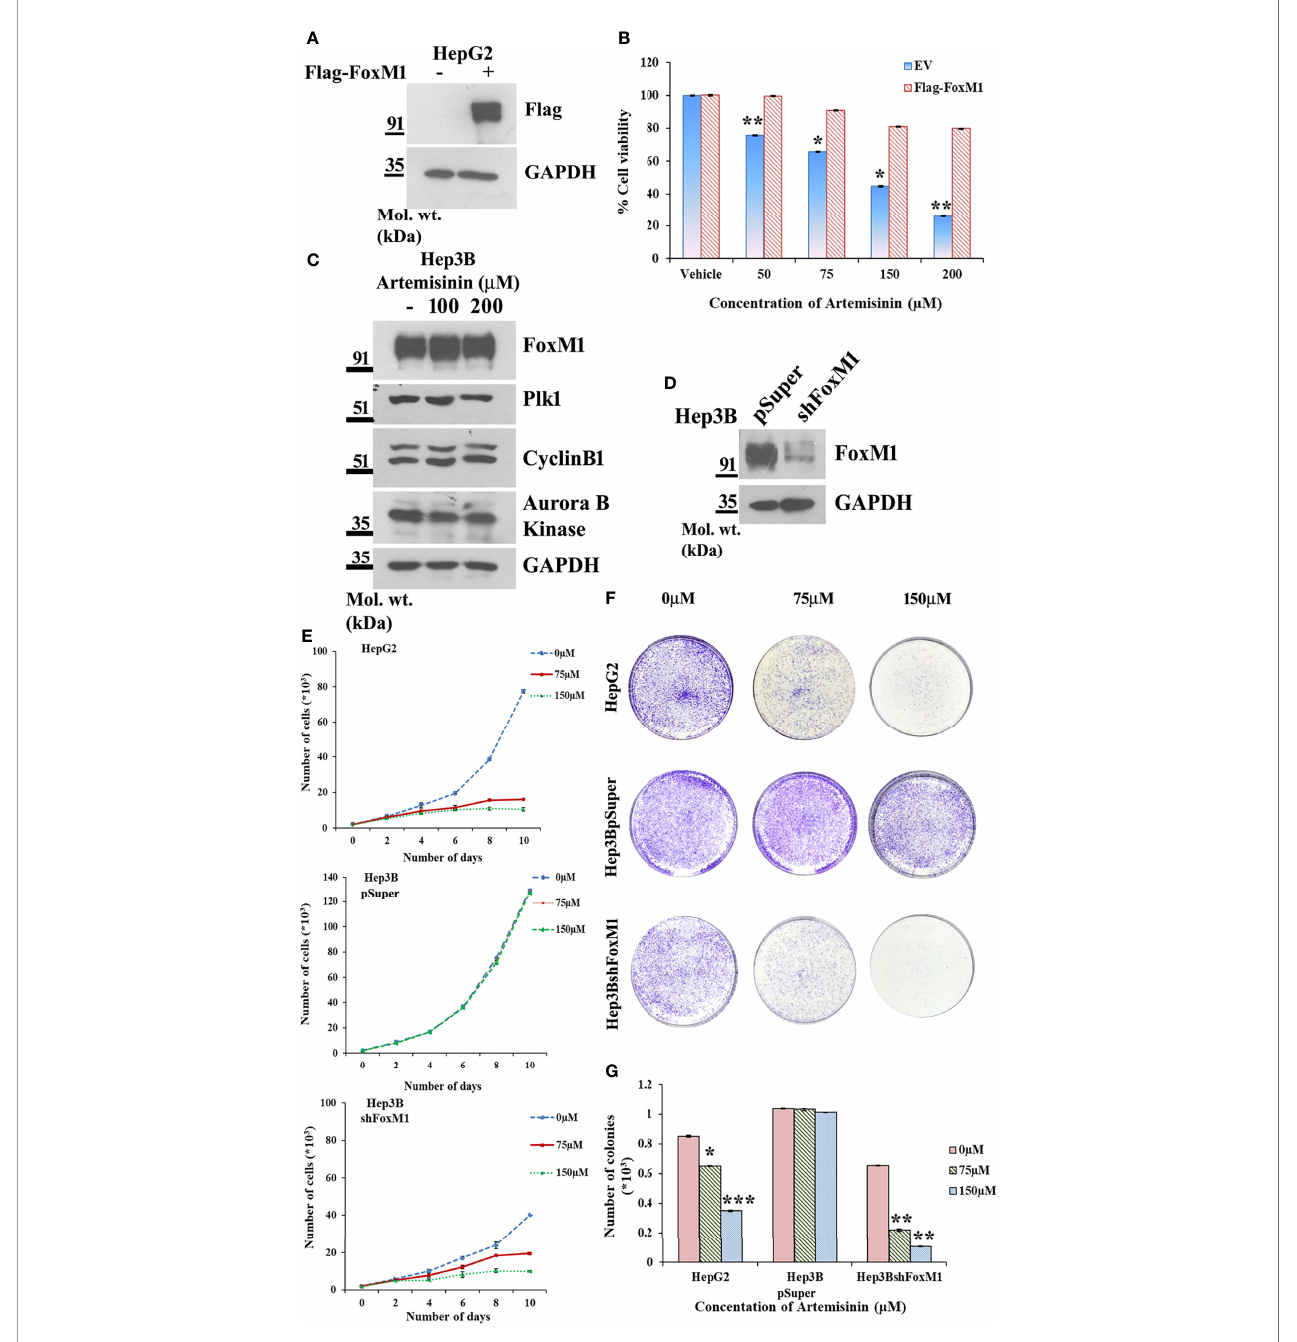
FIGURE 3 | FoxM1 level contributes to Artemisinin-mediated mitigation of cancerous properties of HCC cells. (A) HepG2 cells were transiently transfected with either empty vector or Flag-FoxM1. Equal amount of whole cell lysate was subjected to SDS-PAGE and subsequent immunoblotting for FoxM1. GAPDH was used as a loading control. (B) HepG2 cells overexpressing either empty vector or Flag-FoxM1 were treated with increasing doses of Artemisinin for 48 h and cell viability was examined using MTT assay. (C) Hep3B cells were treated with either vehicle or Artemisinin (100 and 200 µM) for 48 h. Equal amounts of whole cell lysates were subjected to SDS-PAGE and western blotting with antibodies speci fi c for FoxM1 and its transcriptional targets, such as Plk1, cyclinB1 and Aurora B kinase. GAPDH was used as a loading control. (D) Immunoblotting showing the ef fi ciency of FoxM1 knockdown in Hep3BshFoxM1 stable cell line relative to control Hep3BpSuper cells. (E) The comparative proliferative rates of HepG2, Hep3BpSuper and Hep3BshFoxM1 cells following exposure to Artemisinin for 48 h. (F) Representative images and (G) graphical presentation of the stained colonies formed by Artemisinin-treated cells after clonogenic assay. * p < 0.05, ** p < 0.01 and *** p < 0.001. All data are expressed as the means ± standard deviations from triplicate experiments. The two-tailed Student ’ s t -test was used to determine whether the differences between vehicle-treated set and Artemisinin-treated set were signi fi